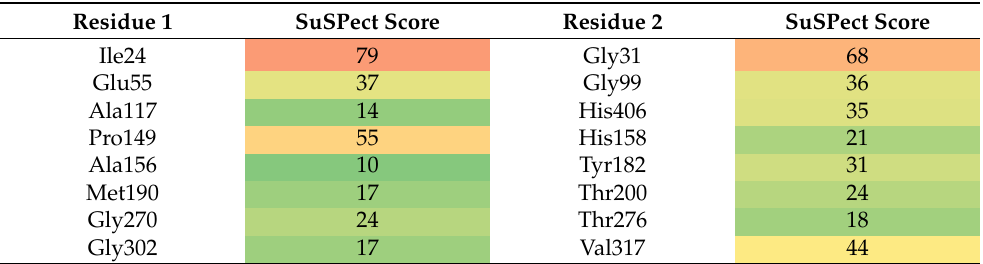
100: predicted deleterious